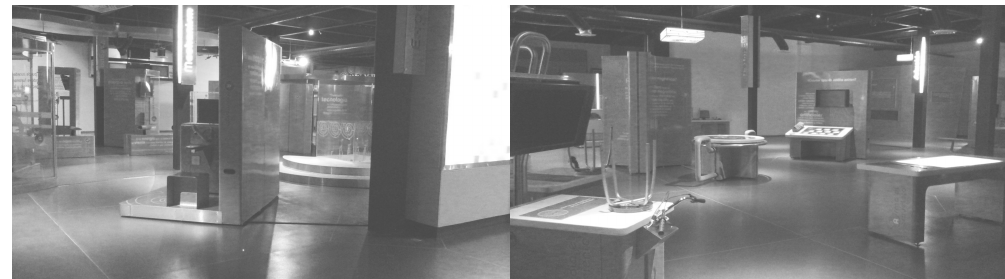
Figure 5. Interactive museum, ILM scenario.